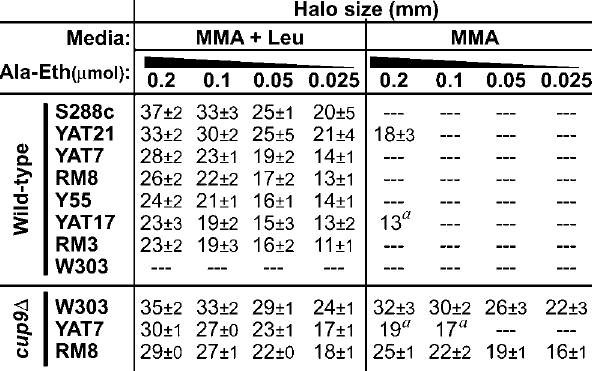
Figure 7. Halo Assay for Uptake of the Toxic Ala-Eth Dipeptide Cells were plated onto MMA with or without 30 l g/ml leucine, an inducer of PTR2 expression. Halo diameters in the presence of discs containing the indicated Ala-Eth concentrations are presented as the mean 6 standard deviation. ( ptr2 D strains were also tested, and exhibited no halos.) a Halo boundary was indistinct, often slowly receding as cells closer to the disc began to grow. DOI: 10.1371/journal.pgen.0010080.g007